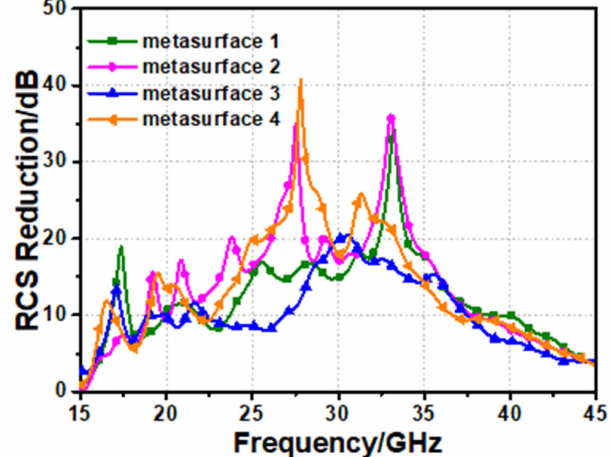
Figure 15. RCS reduction of random coding and random